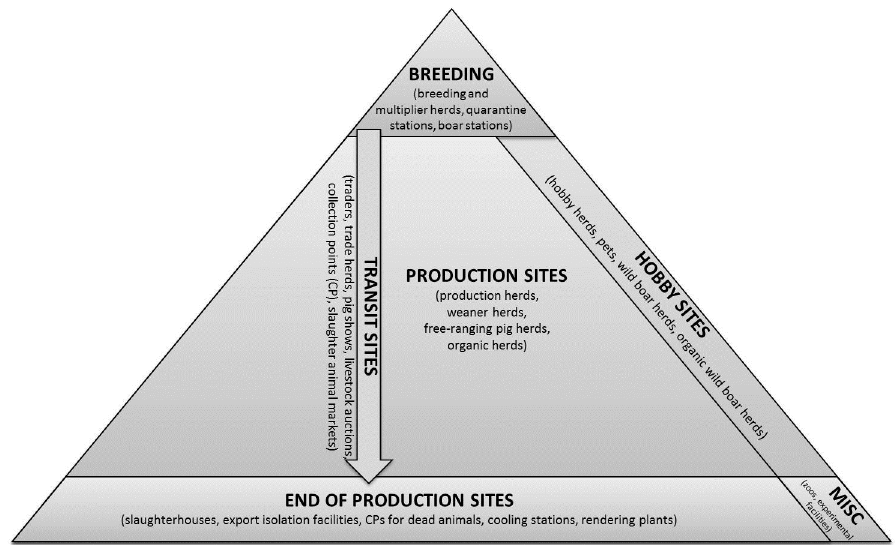
Fig 1. Pyramidal structure of the Danish pig production chain. The 24 holdingtypes consideredin this study were assignedto generic productionsteps. Besidesthe vertical connections, illustratedby the vertical transit sites horizontalconnections also